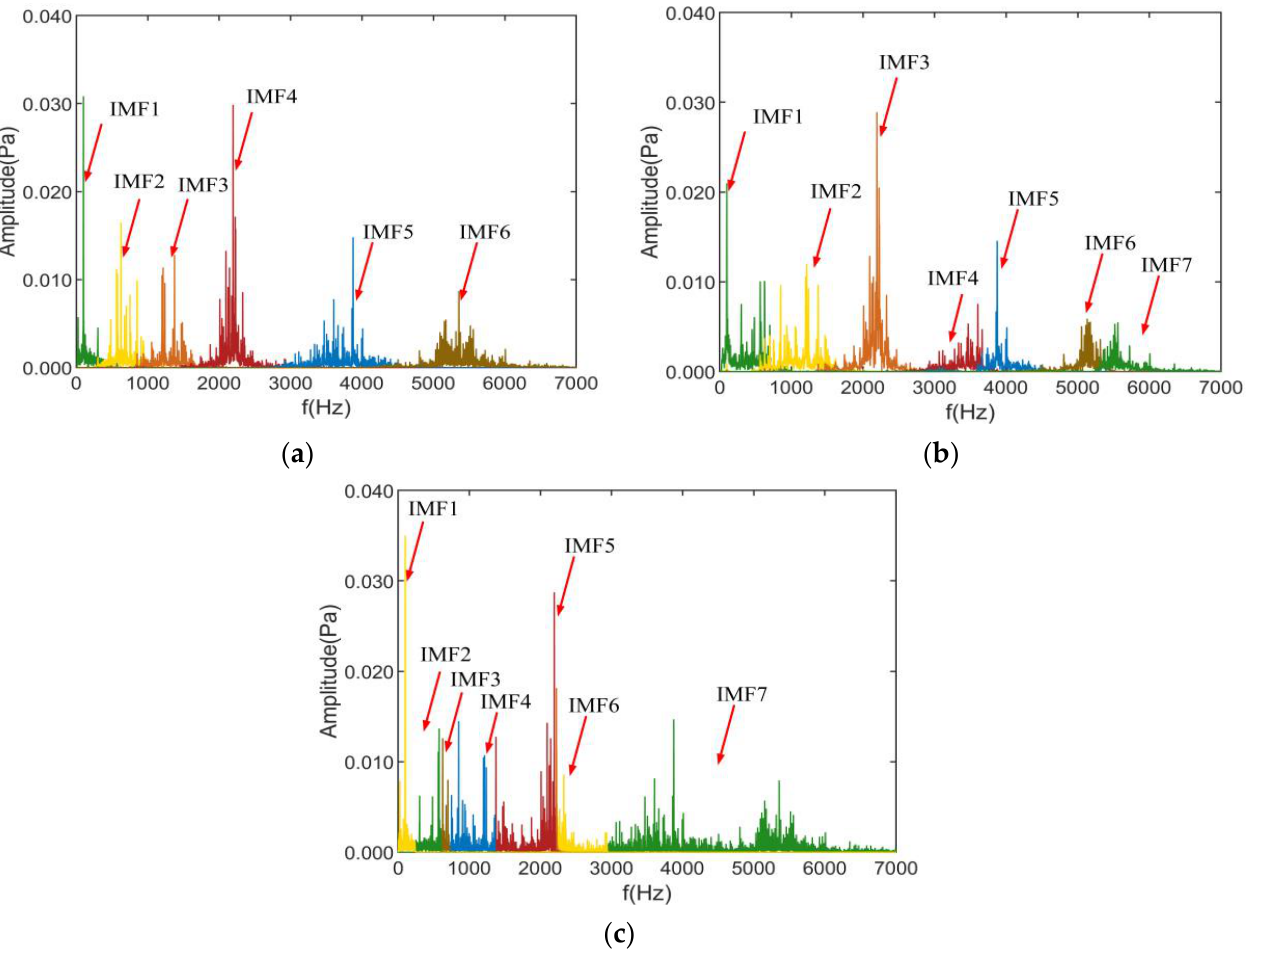
Figure 12. Decomposition results of the three methods: ( a ) ASSME, ( b ) CSSVMD, ( c ) CSSEWT .